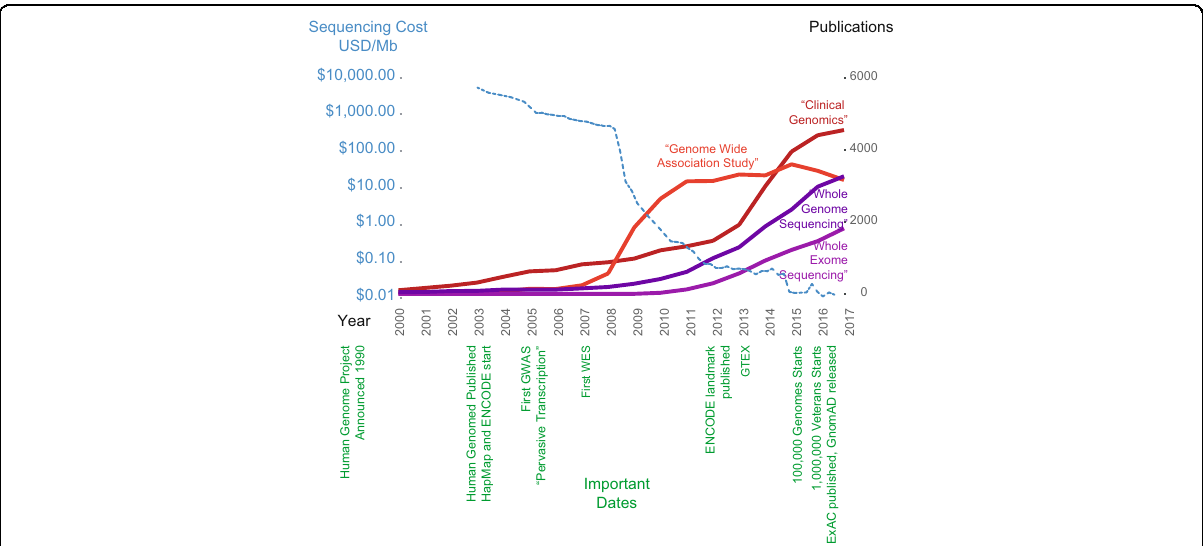
Fig. 1 The rise of genomics at a glance. DNA sequencing costs (blue) over time compared to the number of publications containing speci fi c phrases in PubMed. Some key events in genomics are shown in